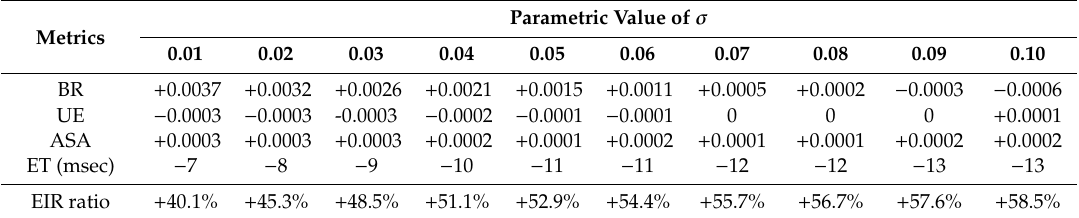
Table 4. Di ff erences of SNIC and ENIC in BR, UE, ASA and ET. “ +/ -” indicate the value of ENIC is greater / smaller than SNIC. Last row shows the ratio of neighboring inspection omitted by